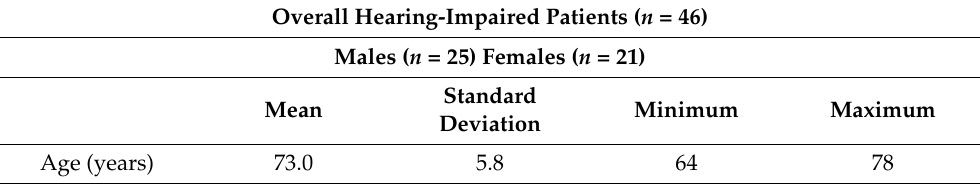
Table 1. Demographic data of the entire